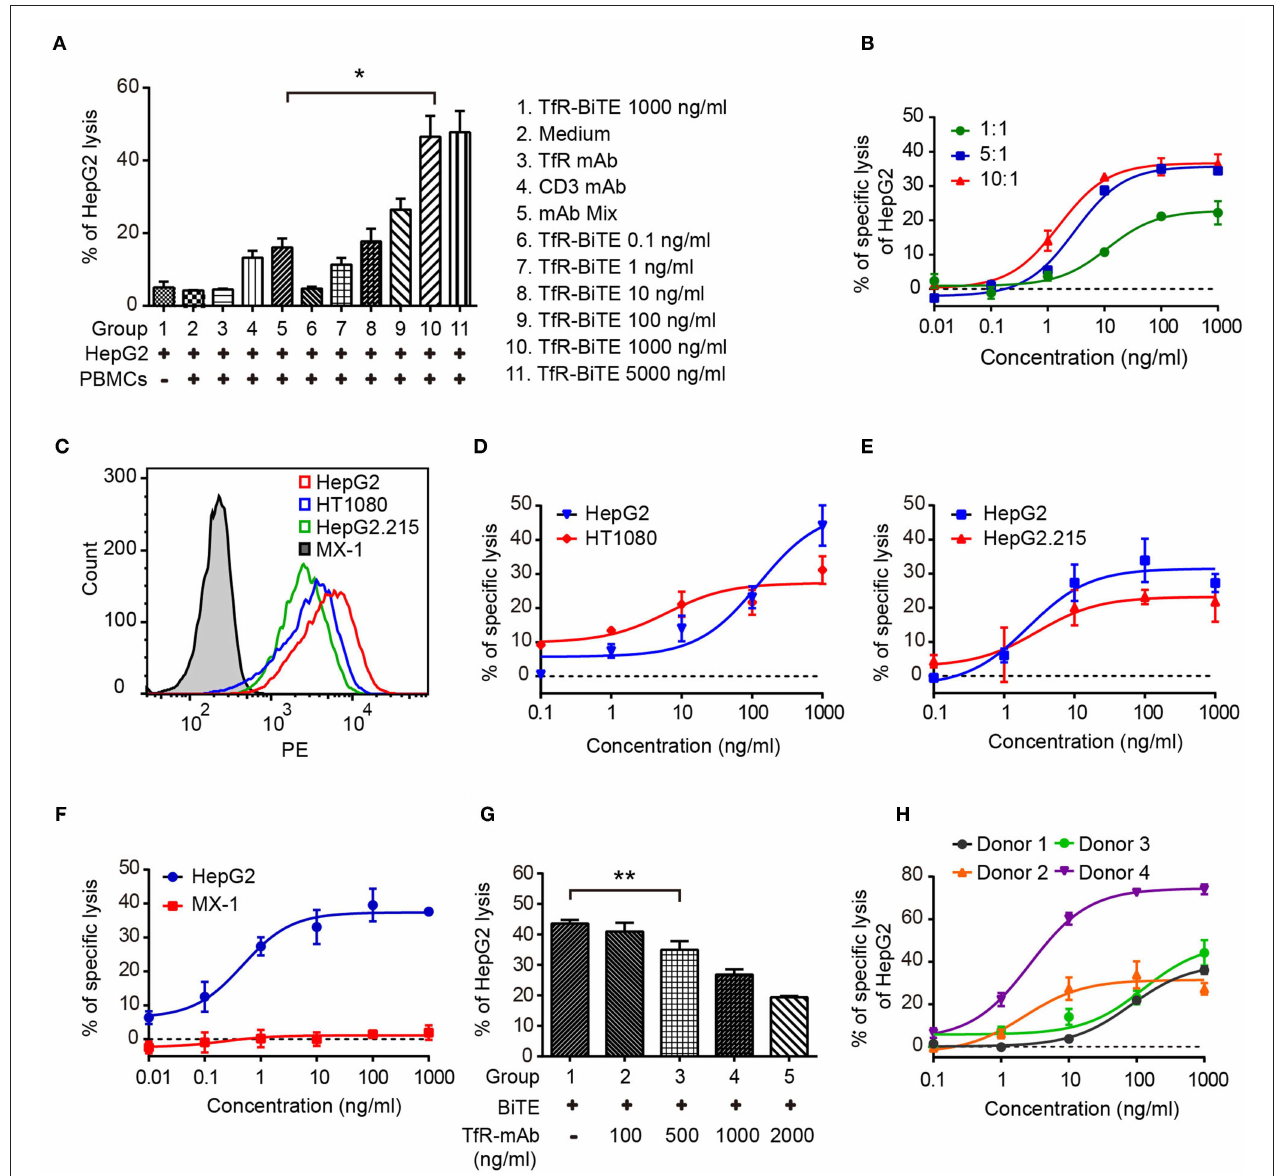
FIGURE 3 | TfR-BiTE mediates cytotoxicity to TfR-positive tumor cells in vitro . (A) CFSE-labeled PBMCs and HepG2 cells (E:T = 10:1) were incubated with antibodies indicated for 24h. Then cells were stained with 7-AAD. CFSE − 7-AAD − cells were calculated as viable tumor cells. The percentage of lysed HepG2 cells was calculated using the formula described in materials and methods. (B) PBMCs and HepG2 cells were co-cultured with different E:T ratios in the presence of TfR-BiTE at indicated concentrations for 48h. (C) The histogram showed the expression of TfR in four tumor cell lines measured by FCM. (D–F) TfR-BiTE (1,000ng/ml) potency against four different tumor cells (HepG2, HT1080 HepG2.215, and MX-1 cells, E:T = 10:1). (G) TfR mAb competitive binding assay. HepG2 cells and PBMCs were incubated with TfR-BiTE (100ng/ml) and TfR mAb at indicated concentrations for 48h. (H) TfR-BiTE potency against HepG2 cells incubated with PBMCs from four healthy donors. The percentage of cell lysis was quantitated by FCM and calculated as described in Materials and Methods. Error bars represent SD of triplicates. * p < 0.05; ** p <